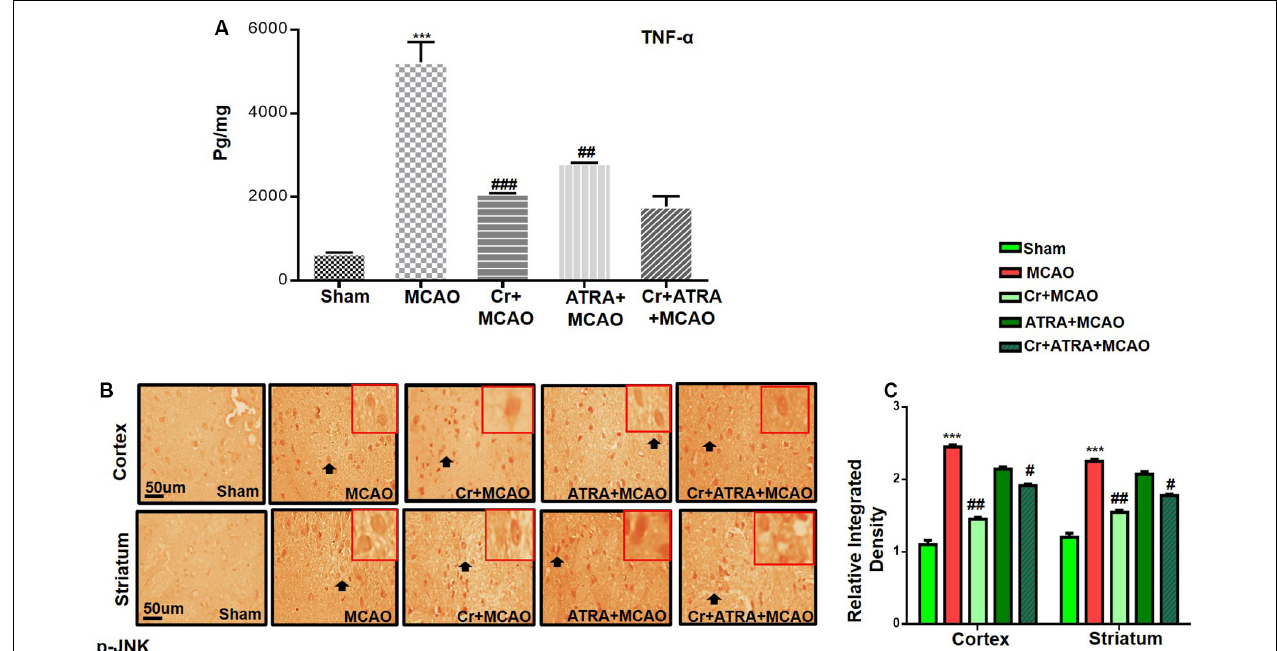
FIGURE 4 | Carveol (20 mg/kg) ameliorated oxidative stress and neuroinflammation. (A) TNF- α expression was quantified by ELISA in the cortex. The data were expressed as the mean ± SEM and analyzed by one-way ANOVA. *** p < 0.001 relative to the sham while ## p < 0.01 relative to the MCAO with n = 5/group. After euthanasia, samples were collected and preserved at –80 ◦ C and later processed for protein analysis. (B) Immunohistochemistry results for pJNK in cortex and striatum tissues of the brain. Scale bar 50 µ m, magnification 40 × ( n = 5/group). p-JNK exhibited cytoplasmic localization in both tissues. Histograms show a comparatively higher expression of p-JNK in various segments of the MCAO and ATRA groups. The data were expressed as the mean ± SEM and analyzed by two-way ANOVA followed by post hoc Bonferroni multiple comparison test using GraphPad Prism 6 software. *** p < 0.001 shows significant difference relative to sham, while # p < 0.05, ## p < 0.01 and ### p < 0.001 shows significant difference relative to MCAO group. Immuno slides were made by processing TTC thick coronal sections which were fixed in 4% paraformaldehyde. From the thick coronal TTC sections, paraffin blocks were made, and later 4 µ m thin coronal sections were prepared by a rotary